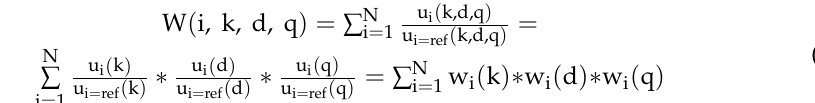
Weight in Utility